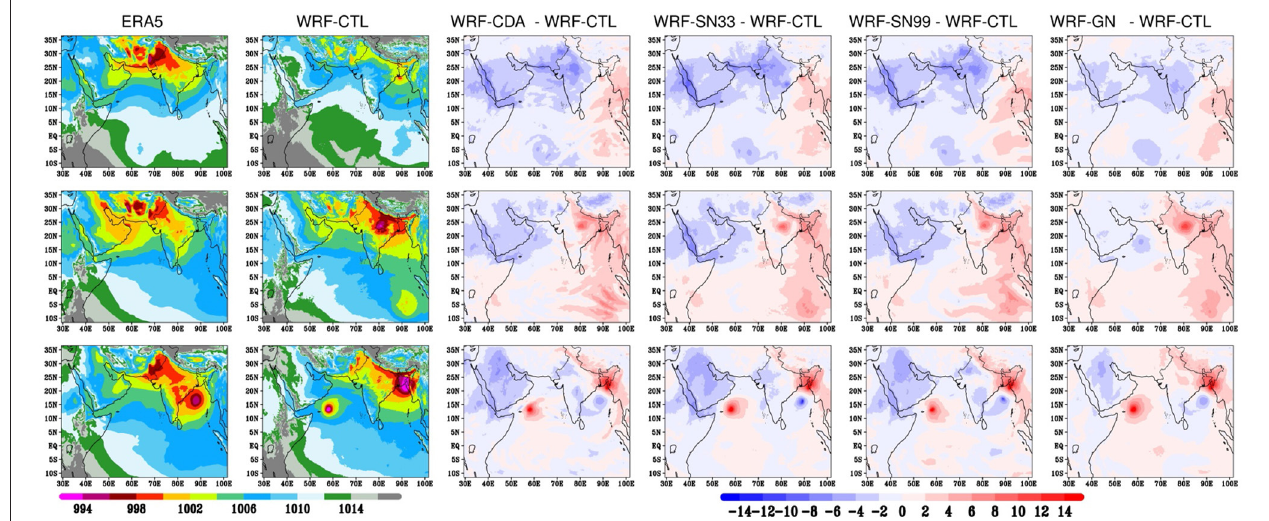
FIGURE 1 | The mean seas level pressure (hPa) of ERA5 (First column) and WRF-CTL (Second column), and the differences in the mean sea level pressure between the WRF-CDA and WRF-CTL (Third column), WRF-SN33 and WRF-CTL (Fourth column), WRF-S99 and WRF-CTL (Fifth column), and WRF-GN and WRF-CTL (Sixth column) during normal (2016), excess (2013), and drought (2009) Indian Summer Monsoon seasons. First row is for normal, second row is for excess, and third row is for drought Indian Summer Monsoon seasons.